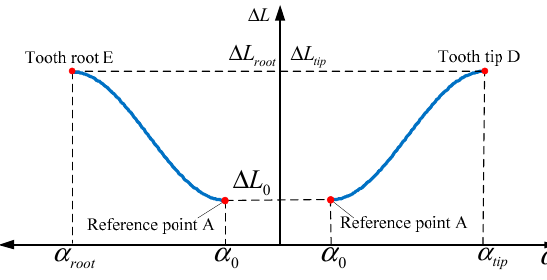
Figure 7. Second cycloid relationship between the modification and pressure angle.